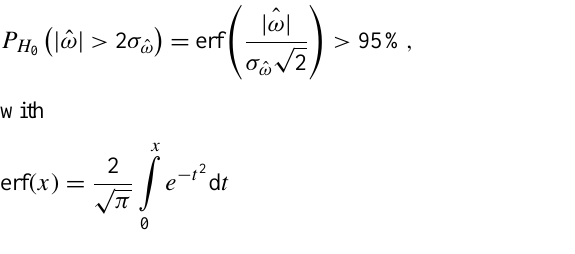
Fig. 13: Comparison of levelshift offset δ between the orig- inal (left) and resolution-corrected (right) GOME measure- ments and the SCIAMACHY dataset.